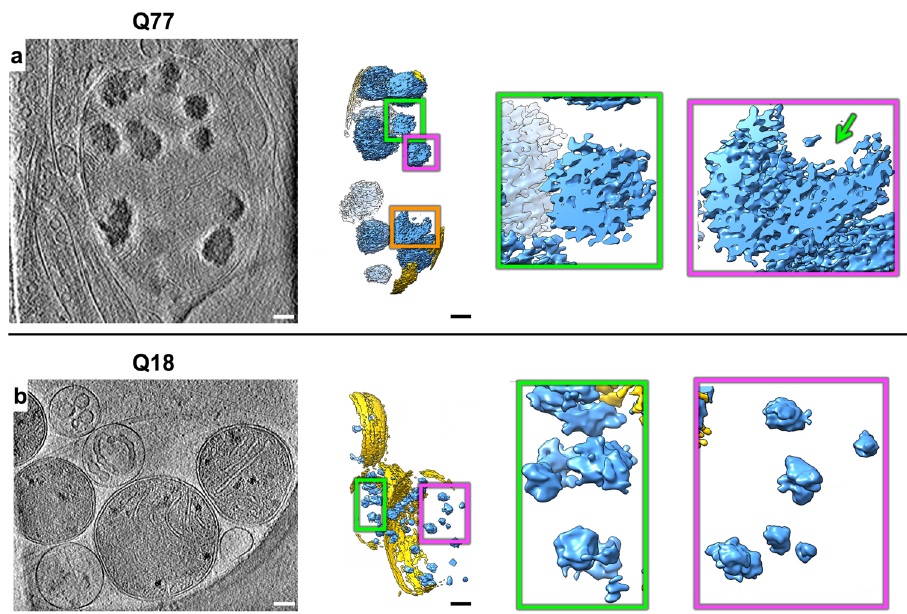
Fig. 2 | Mitochondria in HD neurites contain enlarged granules composed of tightly packed, heterogeneous densities. Z - slices (~1.4nm thick) through repre- sentative cryoET tomograms of a neurite from a a HD iPSC-neuron (Q77) and b a control iPSC-neuron (Q18), and corresponding oblique cutaway-view